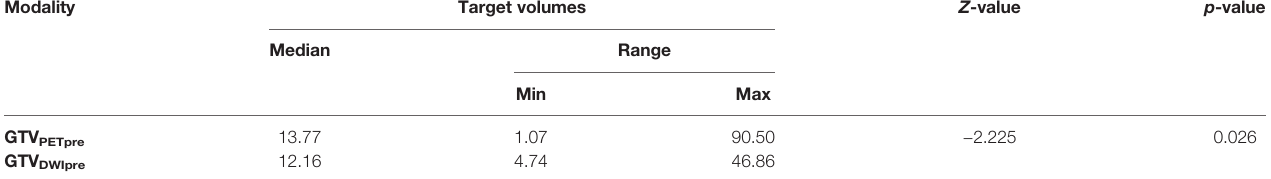
TABLE 5 | Summary of the volume of GTVs contoured using PET-CT and DW-MRI before and during radiotherapy. Modality